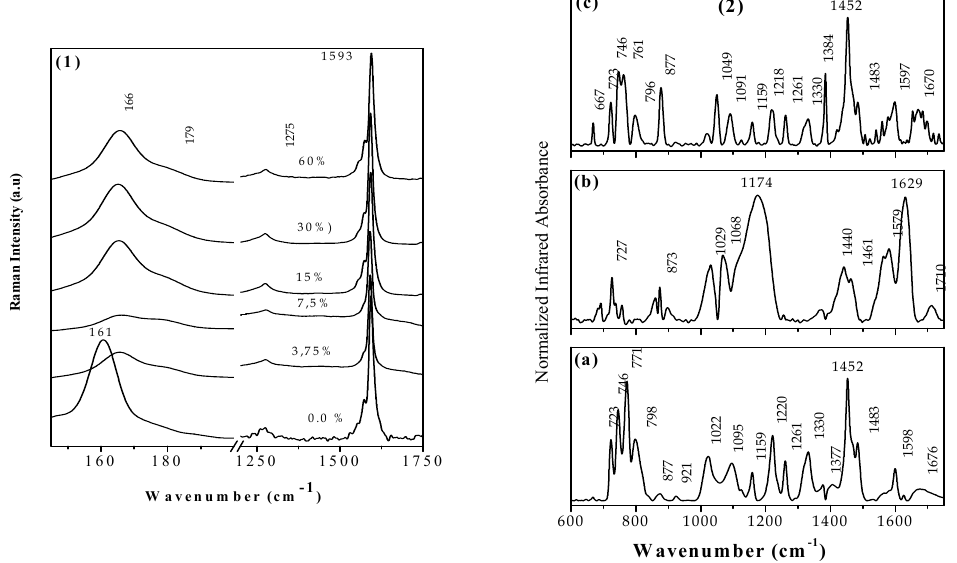
Figure 9. ( 1 ) Raman spectra of PVK-HT/SWCNTs at different CNT weight concentrations (0%, 3.75%, 7.5%, 15%, 30%, and 60%). ( 2 ) FTIR spectra of PVK-HT ( a ), SWCNTs ( b ), and PVK-HT/SWCNT composite (60%) ( c ).